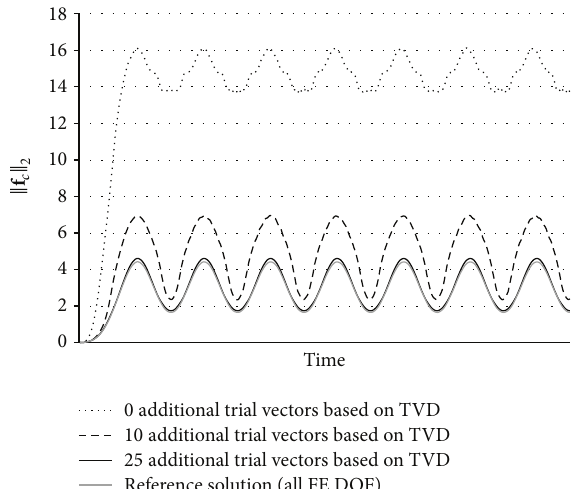
Figure 9: Time evolution of the Euclidian norm of the contact force vector.